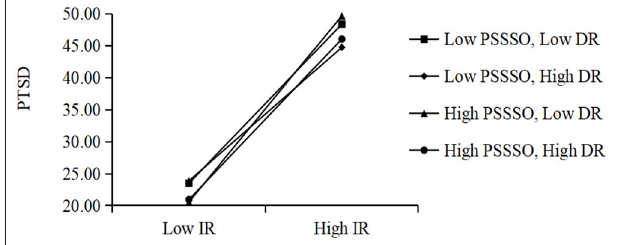
FIGURE 4 | Moderation model of deliberate rumination (DR) and intrusive rumination (IR) and perceived social support from significant others (PSSSO) to PTSD